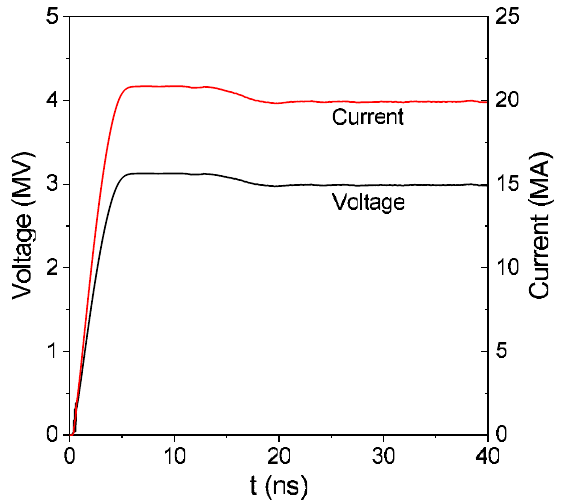
equilibrium values established between 20 and 40 ns.